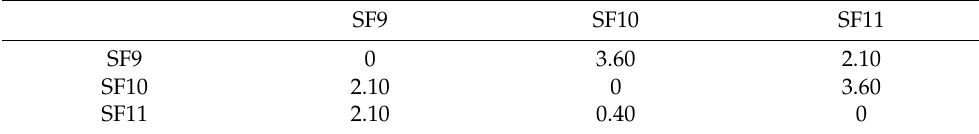
Table A3. Crisp direct-relation matrix—Decision-maker 1 ( Adaptability sub-criteria).